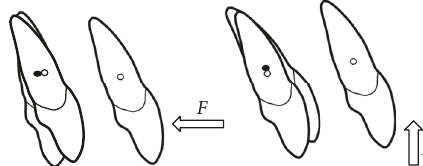
Figure 2: A single force applied to the bracket (not through the center of resistance) will cause rotation of the tooth.